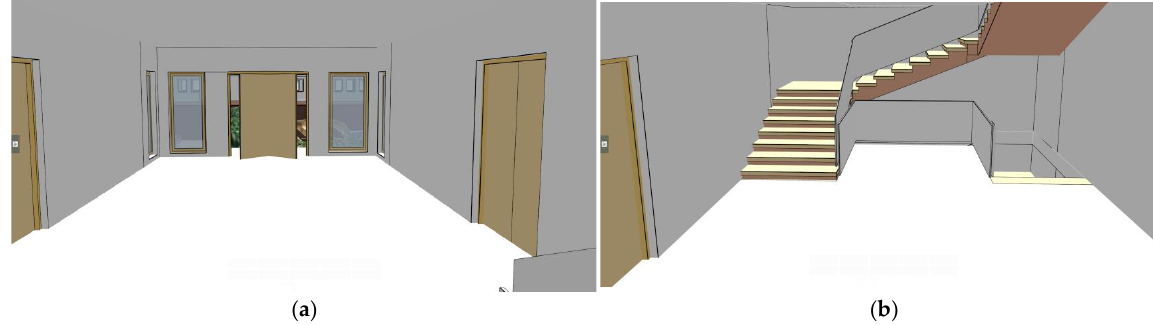
Figure 17. Model output based on the proposed method. ( a ) Visible and ( b ) invisible outdoor scenes.